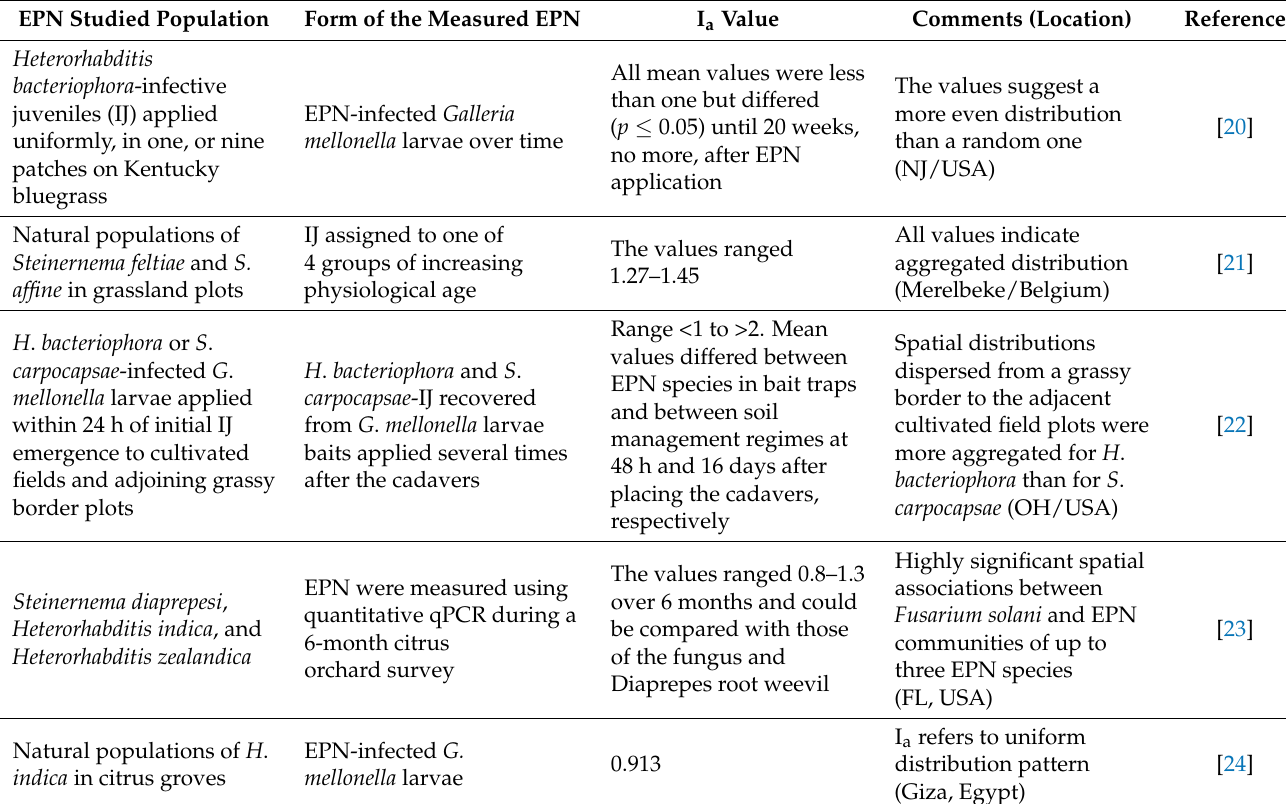
Table 1. Comparison of index of aggregation (I a )* values of five studies on entomopathogenic nematode [EPN] distributions using different sampling approaches in various